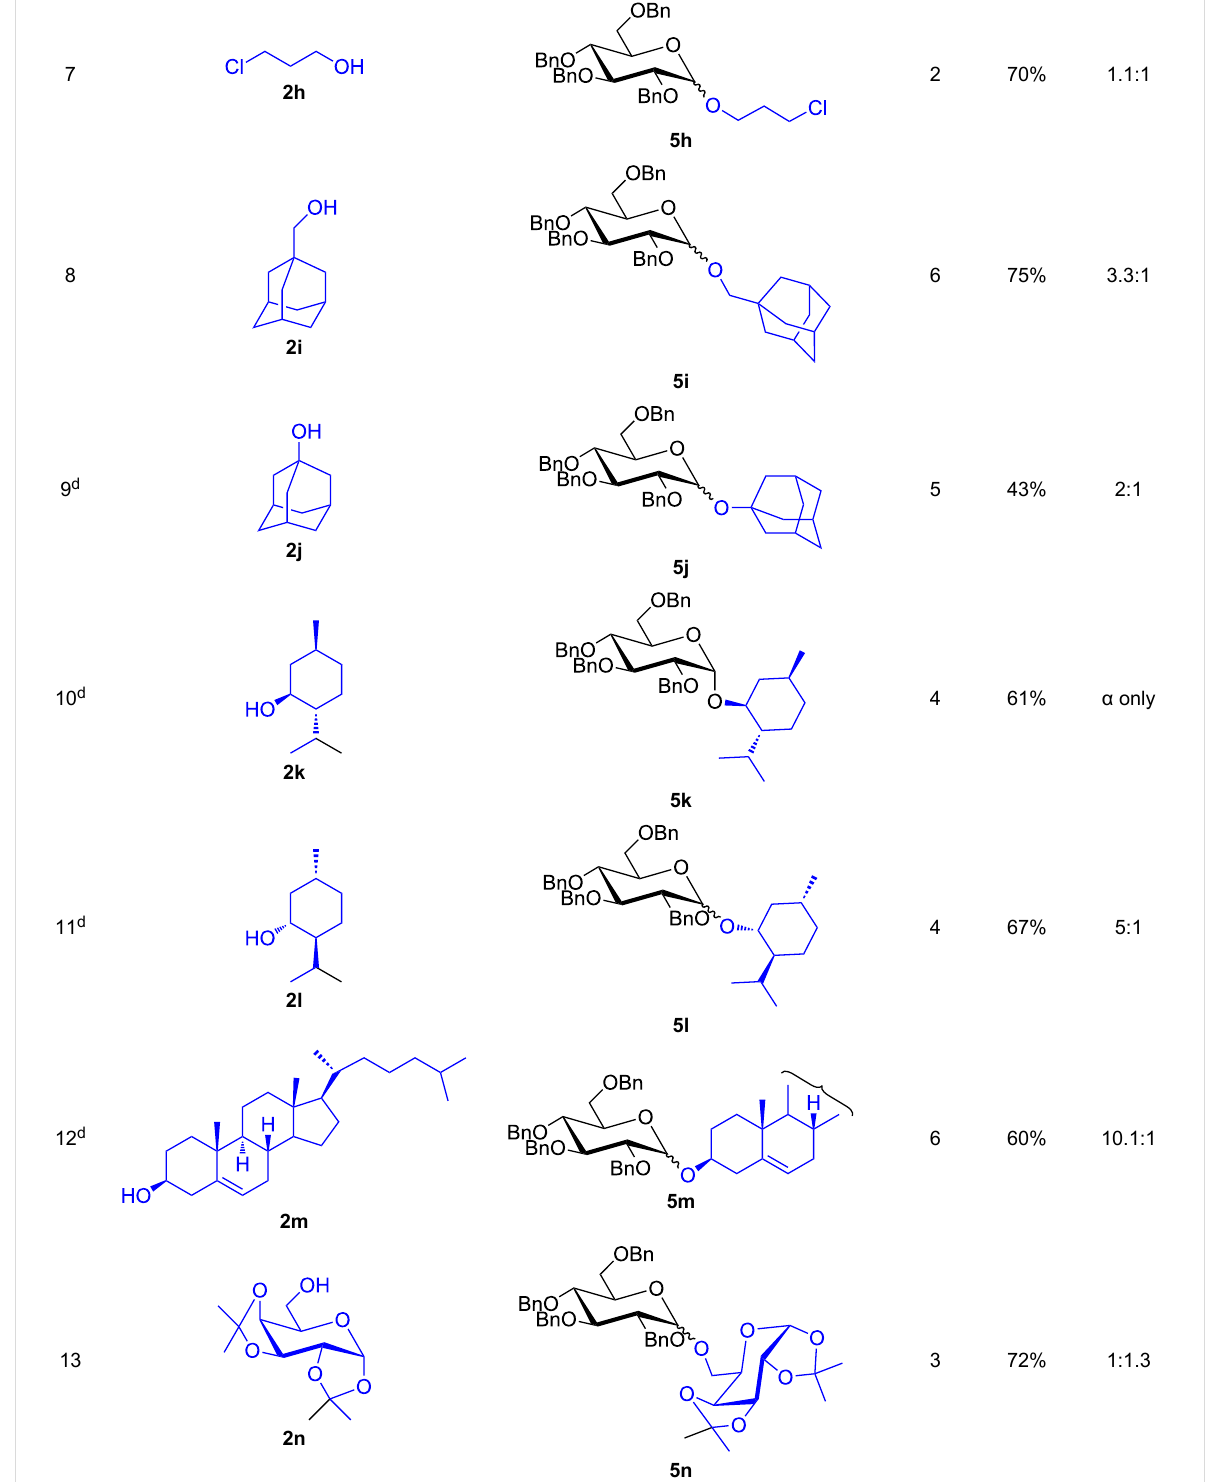
Table 2: Acceptor scope in glycosylation reaction with donor 1 α a .